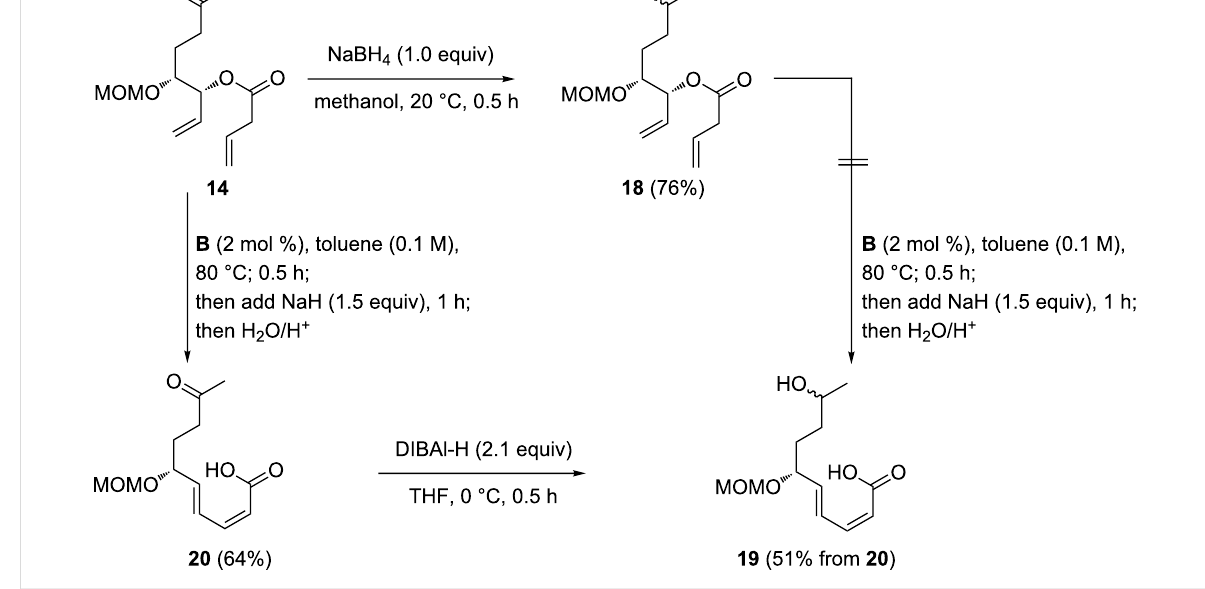
Scheme 4: Synthesis of a substrate 19 for “late stage” resolution.